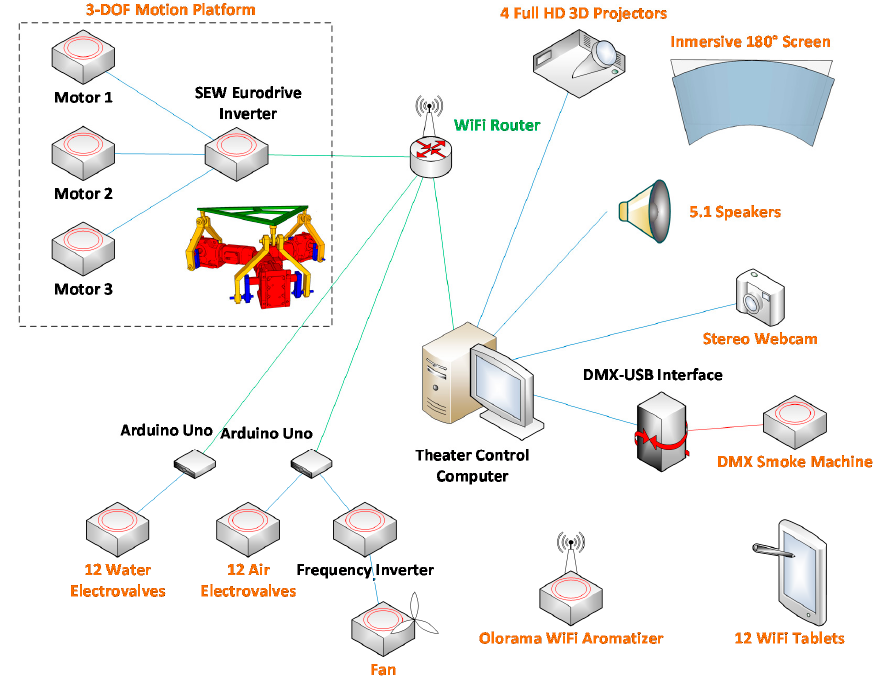
Figure 4. Schema of the multimodal displays and other hardware involved in ROMOT.